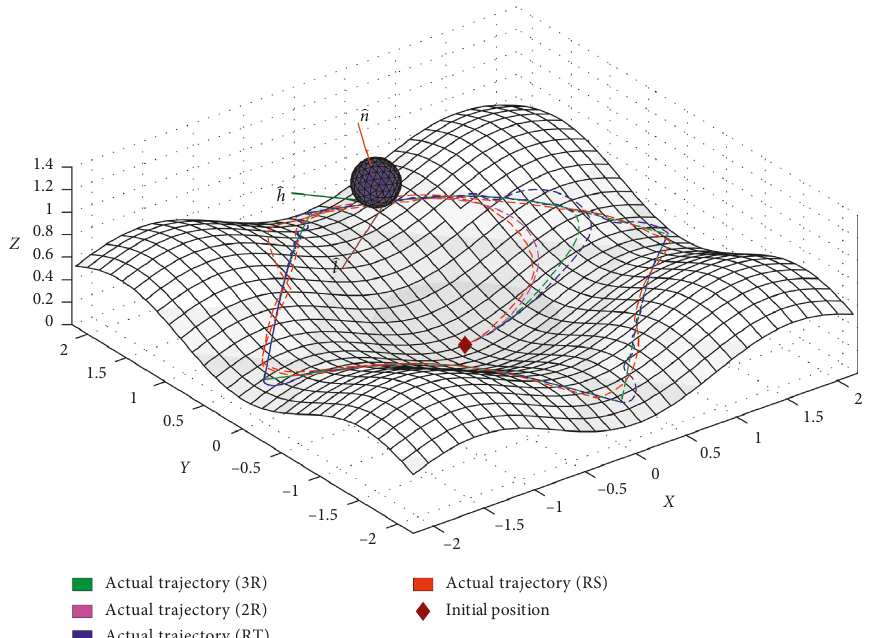
Figure 7: Robots’ actual and desired trajectories on a 3D surface for a path with sharp